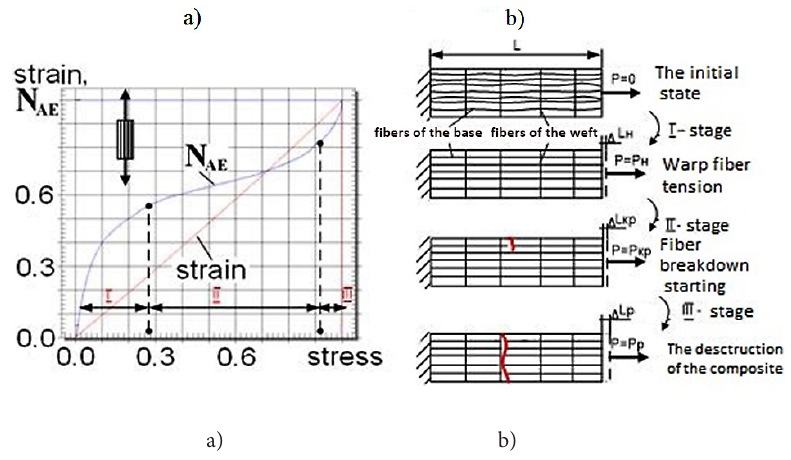
Figure 5. Schedule of changes in the total acoustic emission and deformation from stress (a) and the proposed mechanism for the destruction of the composite in the longitudinal arrangement of the fibres of the base relative to the tensile force